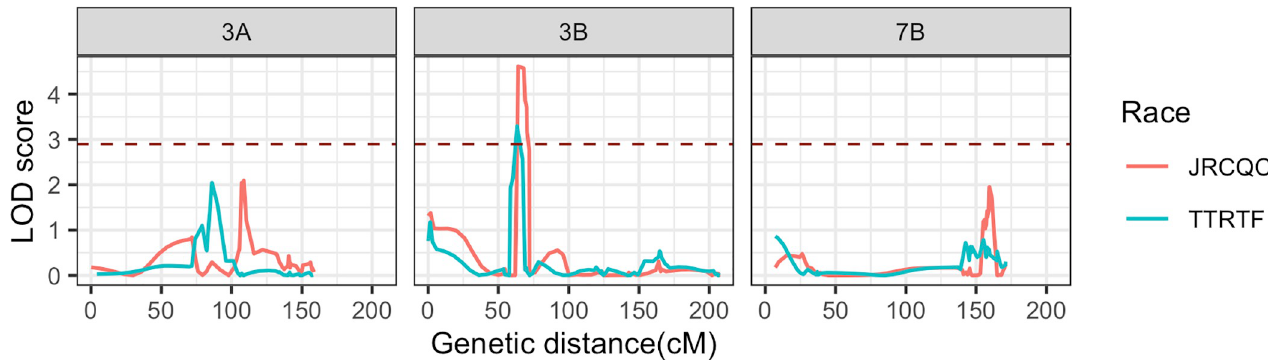
Fig 5. LOD score curves of selected chromosomes from composite interval mapping results for seedling responses to races JRCQC and TTRTF, the brown dotted line indicates the LOD threshold (2.9).